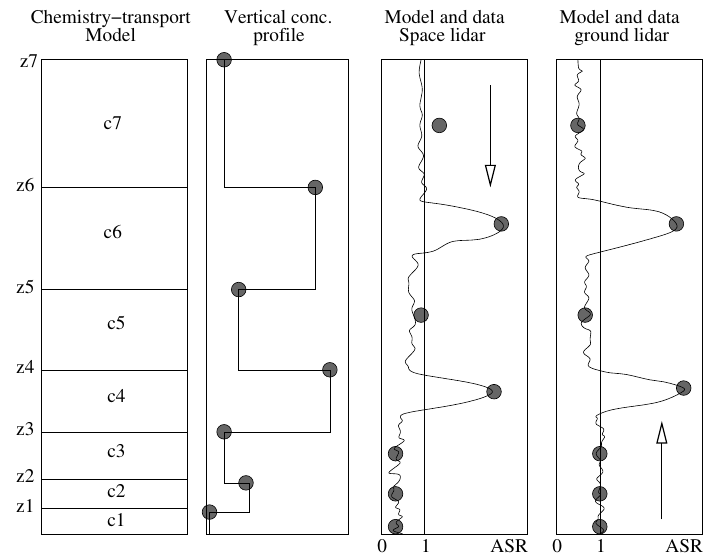
Fig. 1. Overview of the comparison methodology: example of the modelled Attenuated Scattering Ratio (ASR or R 0 (z) ) estimation from initial concentration profiles (middle-left panel) on a specific model vertical grid (left panel) in the case of a space lidar (middle-right panel) or a ground lidar (right panel). The grey dots correspond to the value reported in the model simulation.